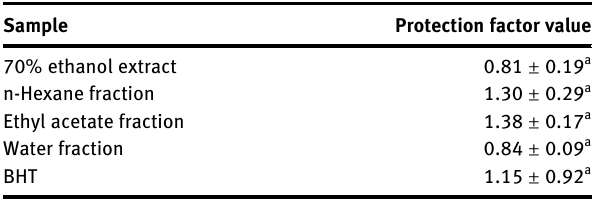
Table  : Rancimat method antioxidant activity of extract and frac- tion of P. crocatum .